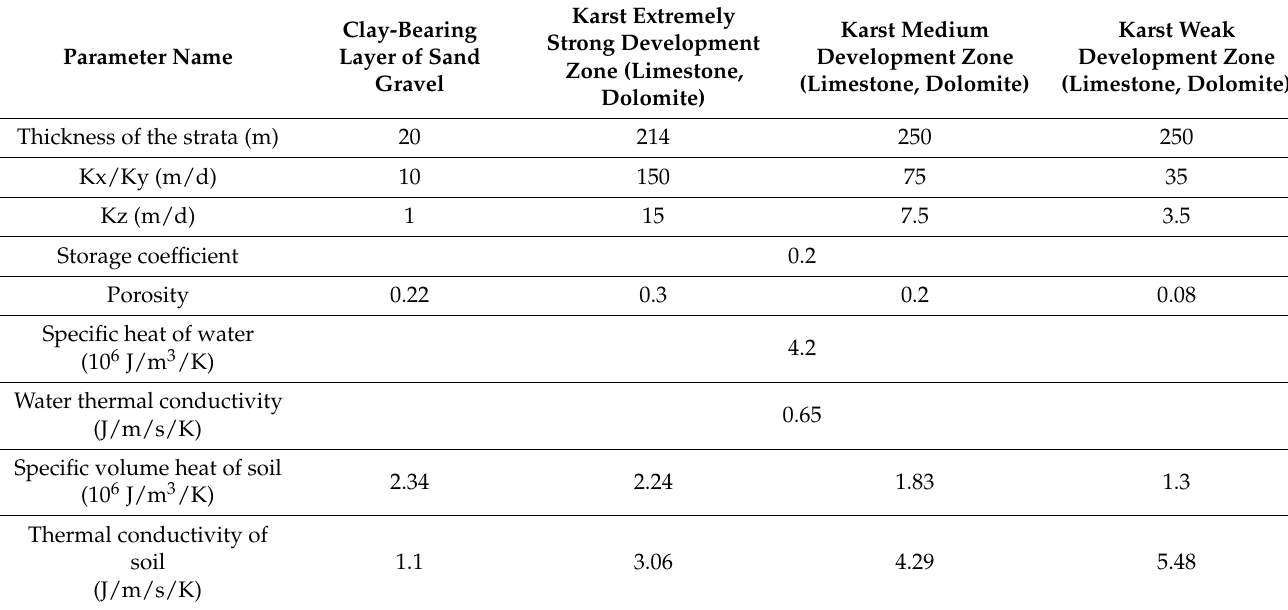
Table 2. Parameters of the numerical